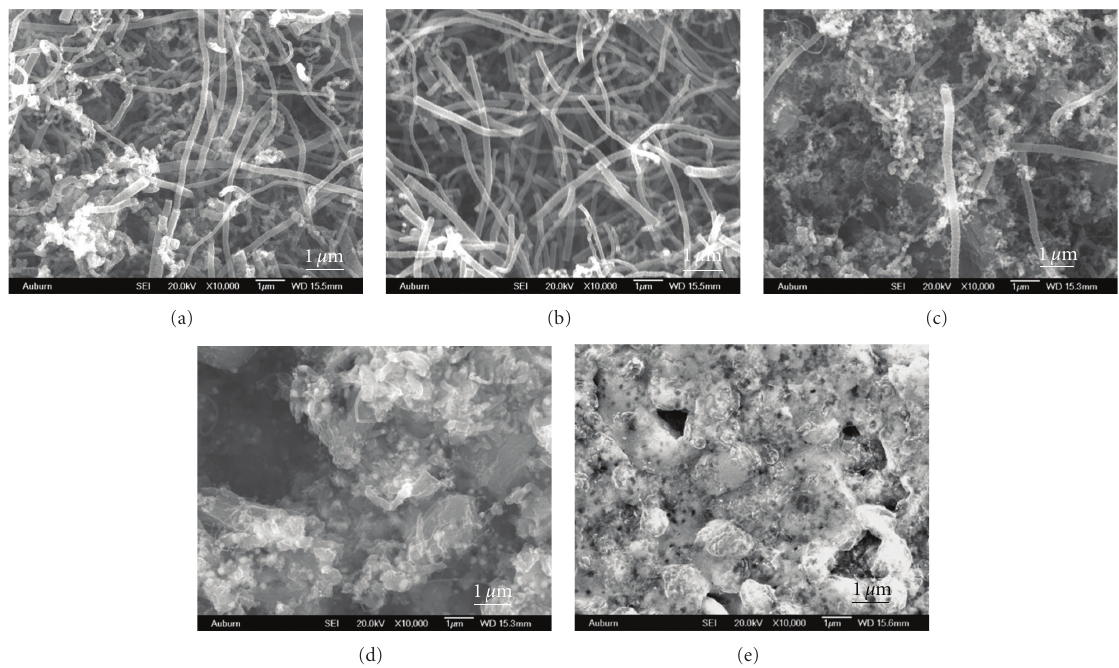
Figure 8: Synthesized CNF for e ff ects of NH 3 during synthesis on 815 ◦ C faceted foil. NH 3 concentration: (a) 0%, (b) 20%, (c) 50%, (d) 80%, and (e) 98%. Synthesis conditions: 570 ◦ C, 2% C 2 H 2 , and remainder H 2 (Table 1 (Phase 4A)).